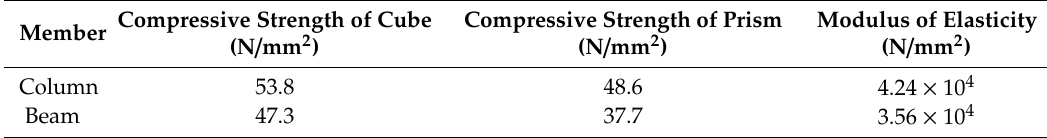
Table 3. The measured mechanical properties of recycled aggregate concrete (RAC).